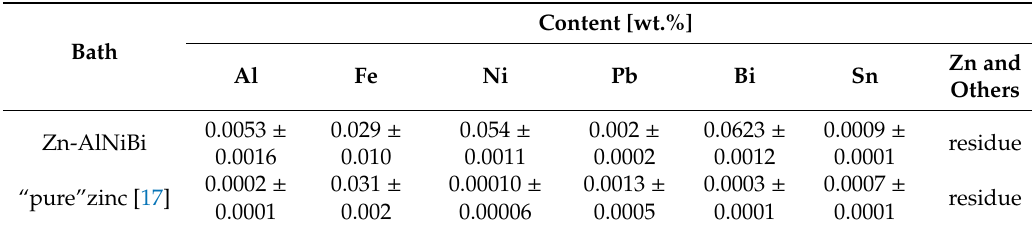
Table 1. The chemical composition of the zinc